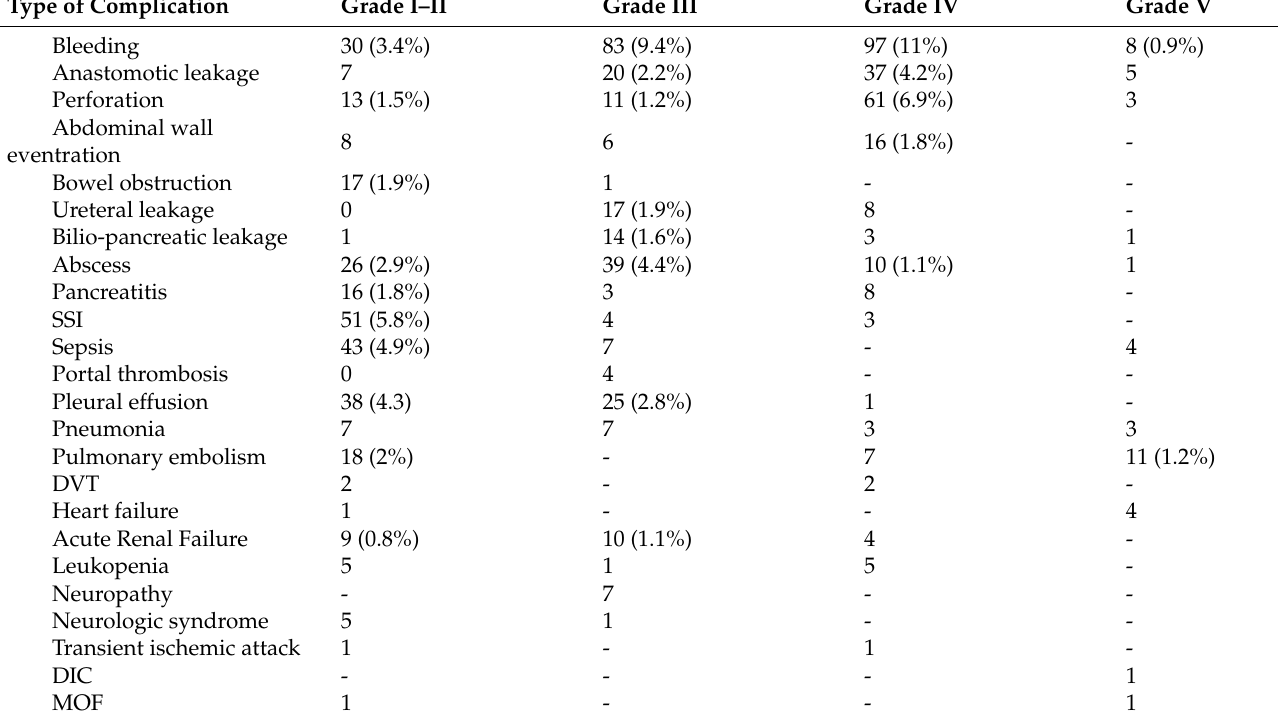
Table 5. Complications grading, N (%), (total 876